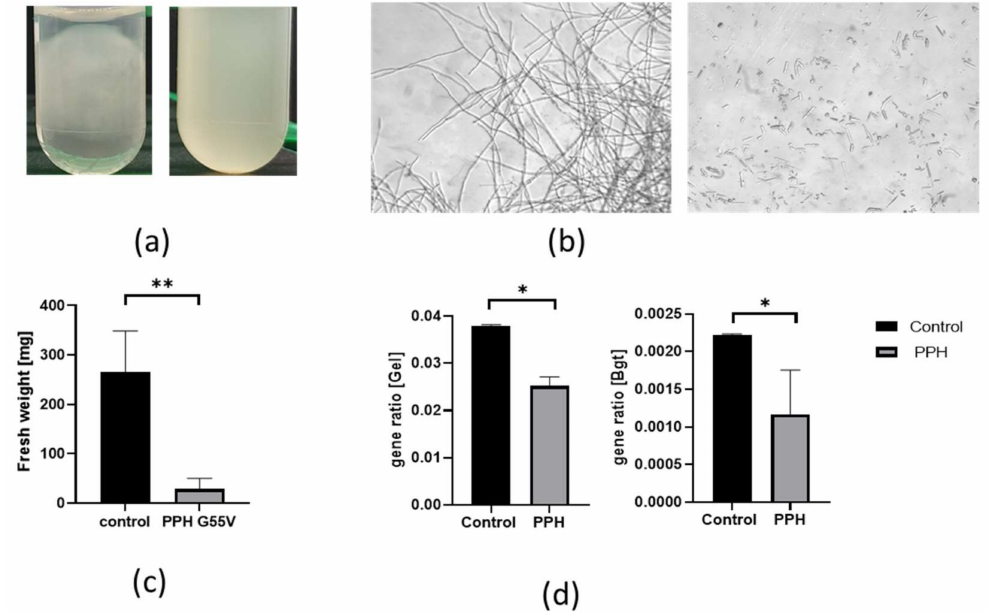
Figure 2. Purified stabilized bacterial lactonase (PPH-G55V) reduced mycelium production and modulated its morphology in PDB medium. ( a ) The addition of 2 µ M PPH-G55V bacterial lactonase to a PDB medium containing ~2500 spores of P. expansum , reduced mycelium production after three days (right tube), compared with untreated culture (left tube). ( b ) Microscopic picture ( × 10), presenting the differences in fungal mycelia development between untreated mycelia (left) and PPH-G55V-treated mycelia (right). ( c ) Fungal mycelium fresh weight was significantly lower in the presence of the lactonase than untreated fungi. (** p =0.0090, t test) ( d ) Expression levels of genes (Gel and Bgt) normalized to housekeeping gene 28 s. Data points represent the means of three biological replicates ± SE. Statistical significance according to one-way ANOVA comparison ( p value = 0.0267 * left, p = 0.0435 * right). Fungi treated with enzyme activity buffer used as